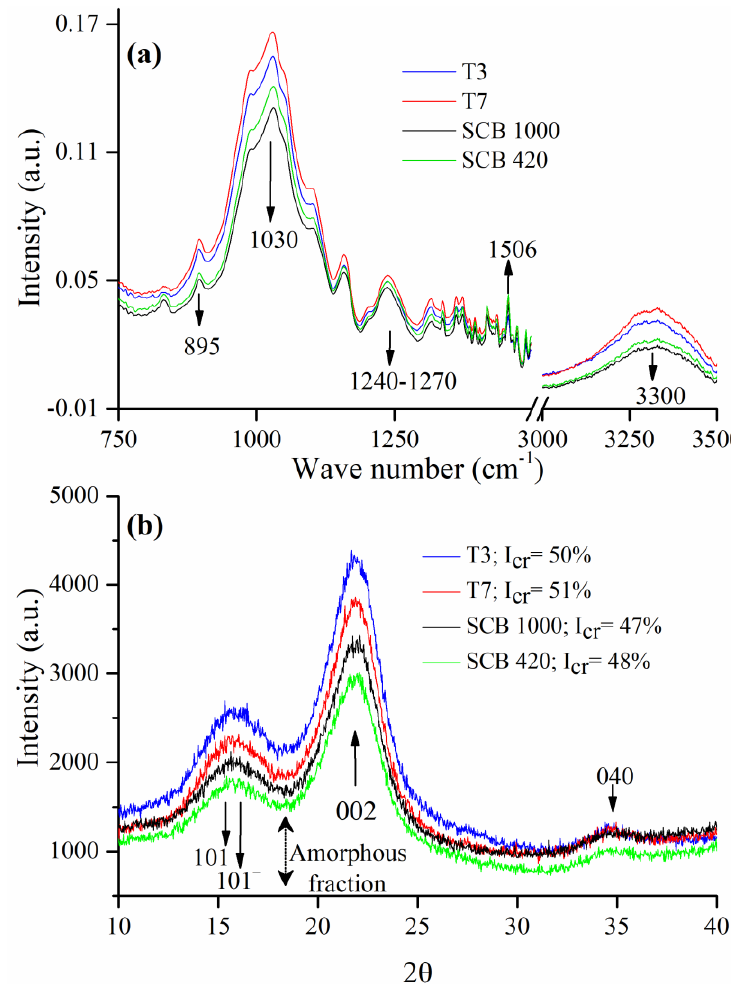
Figure 3. ( a ) Fourier Transformed Infrared (FTIR) spectra and ( b ) X-ray diffractograms and I cr for un- and pretreated SCB samples. Footnote: SCB 1000 and SCB 420 correspond to unpretreated materials with particle sizes of 1000 and 420 µm, respectively.